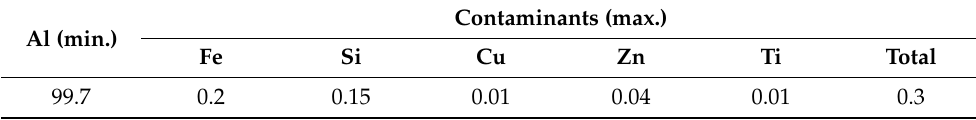
Table 2. Chemical composition of composite matrix—Al 1000 alloy (mass %). Al (min.)